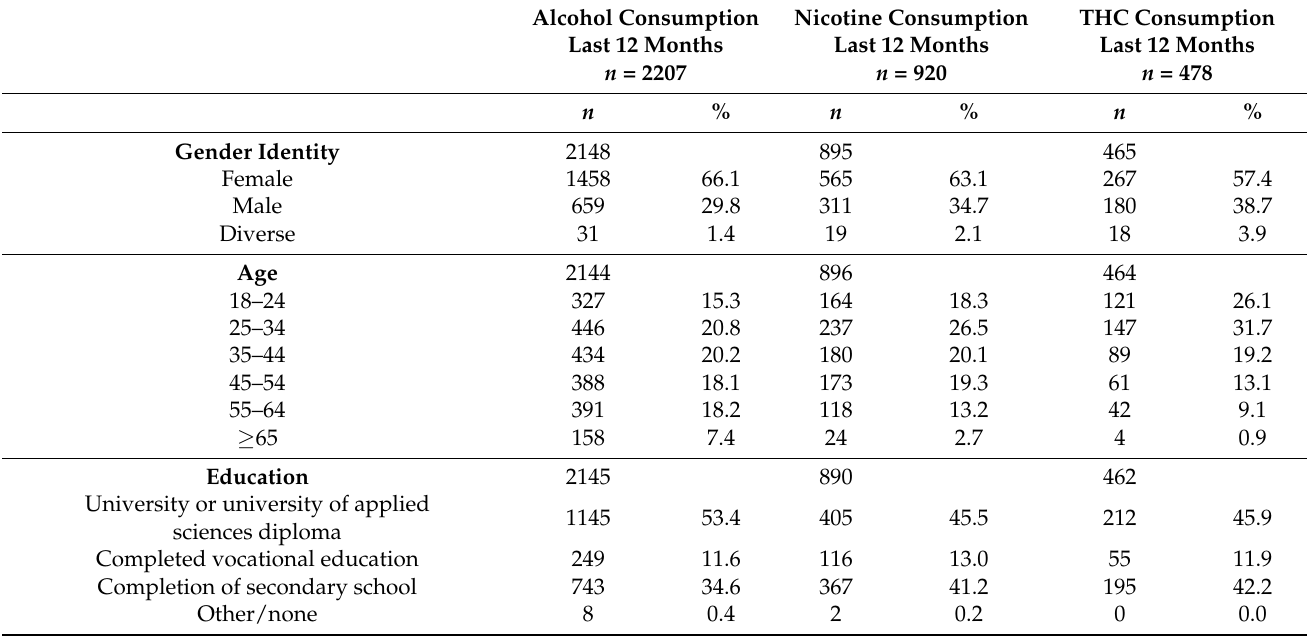
Table 3. Sociodemographic data of persons who used alcohol, nicotine and THC in the last 12